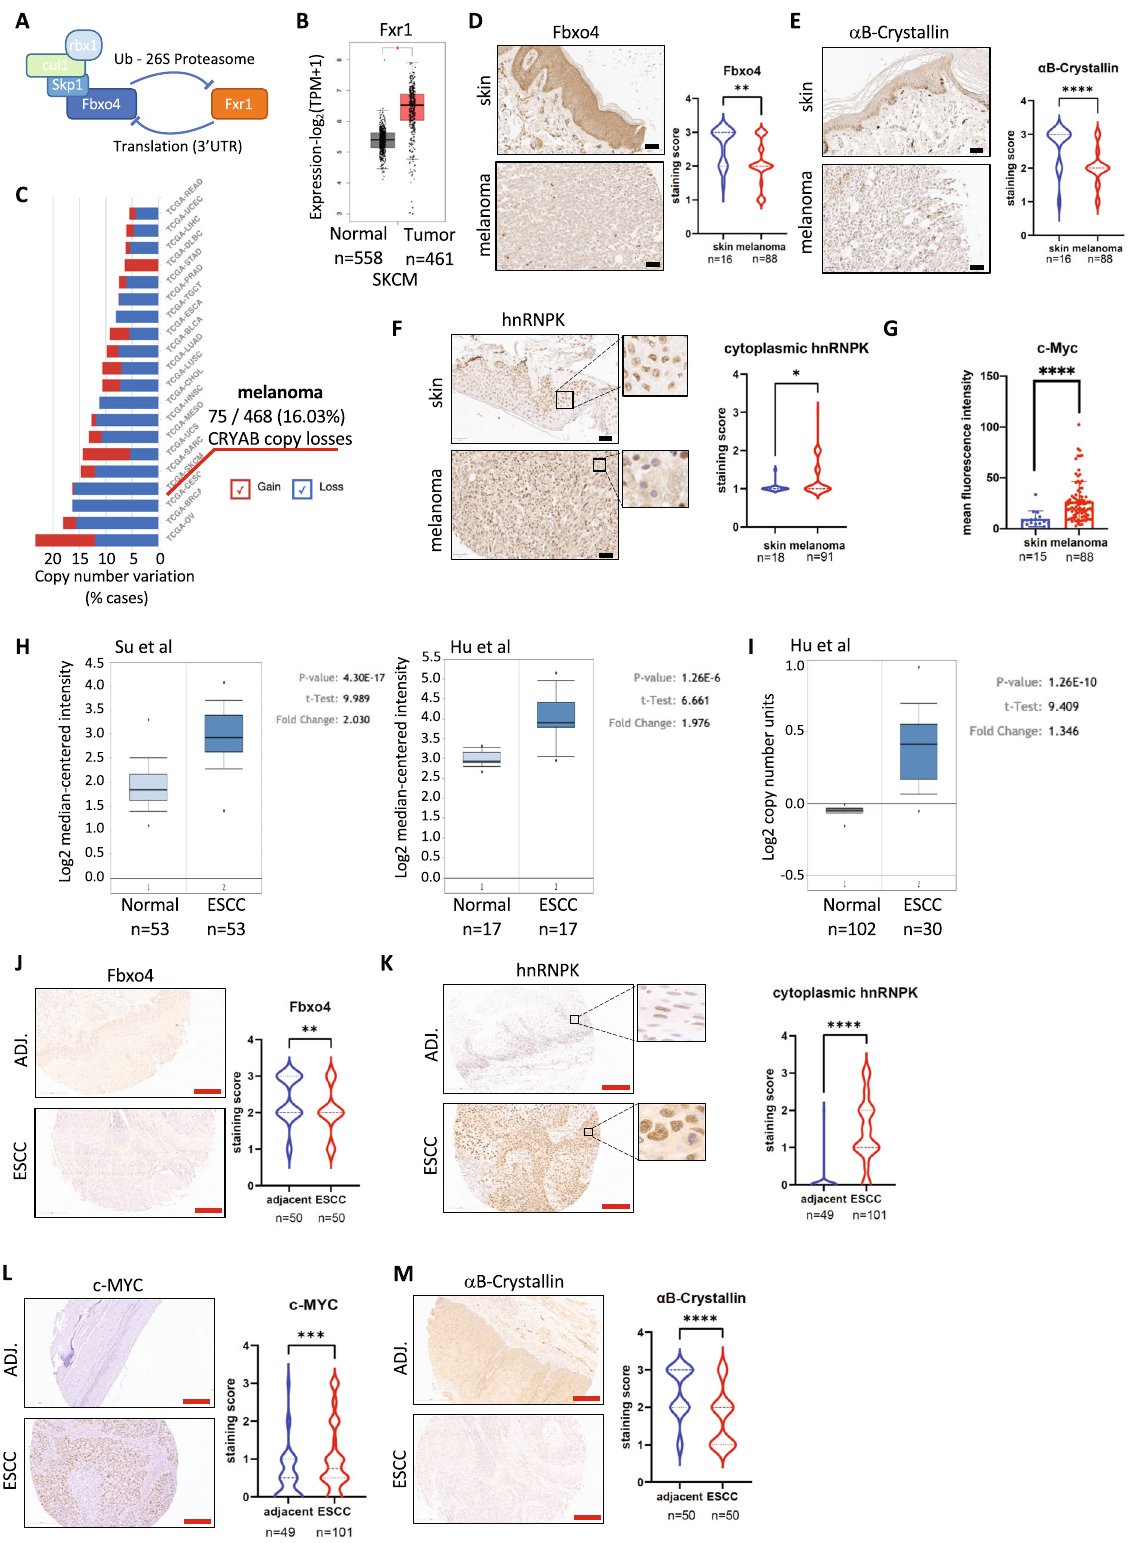
reference- ME2081 and T386a were purchased from US Biomax,